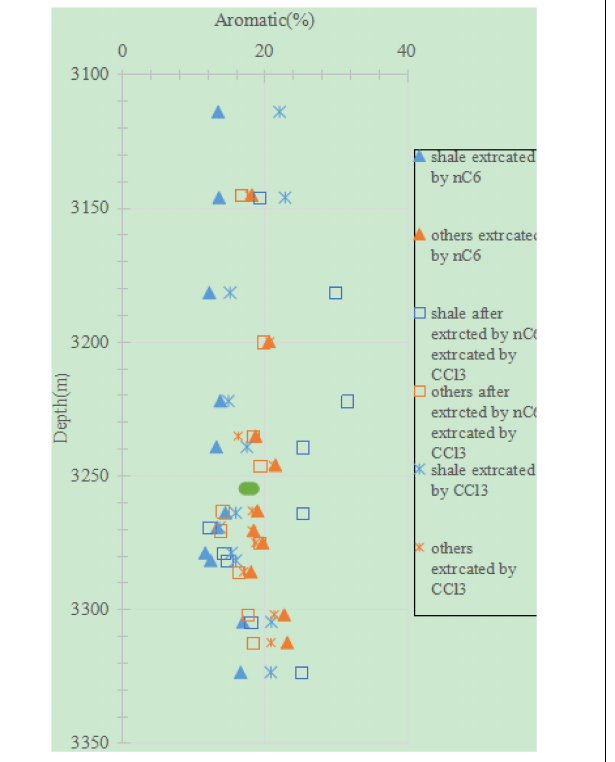
FIGURE 3 | Depth profile of the extract contents of the aromatic hydrocarbon from the mud shale versus the non-mud shale after different extraction